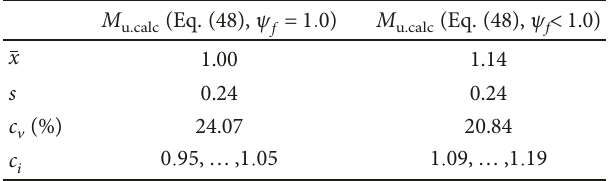
Table 5: Statistical parameters of load-carrying